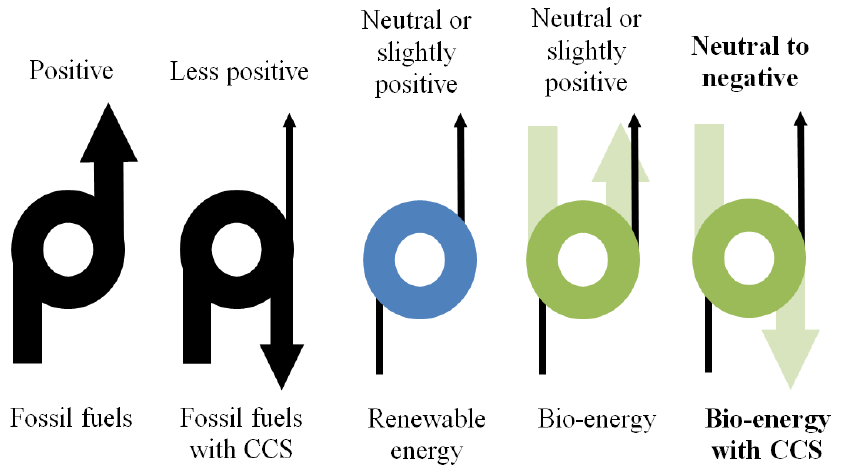
Figure 2. Carbon balance for different energy systems (adapted from [4]).